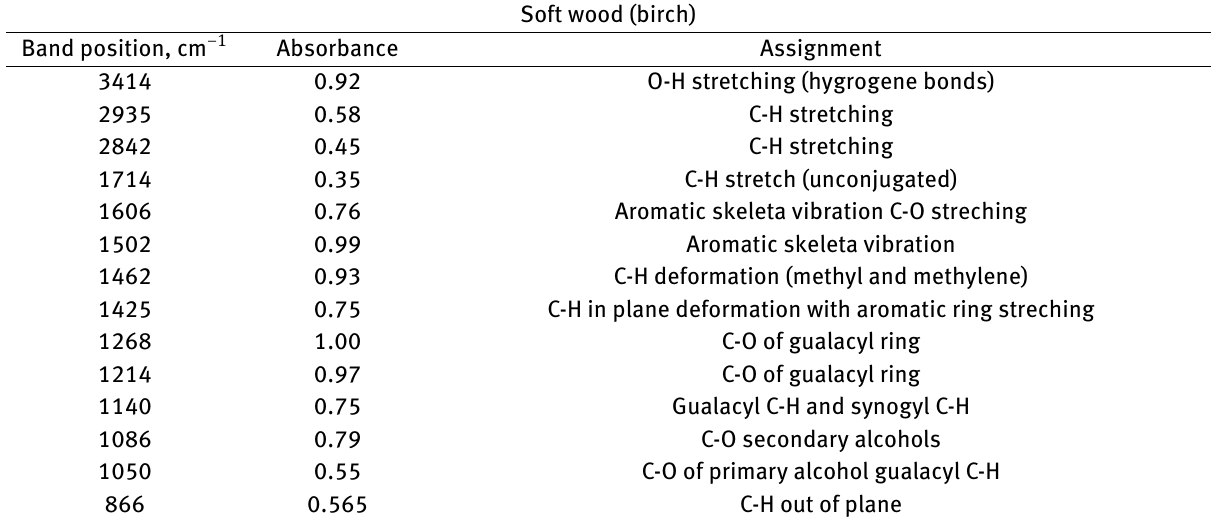
Soft wood (birch)